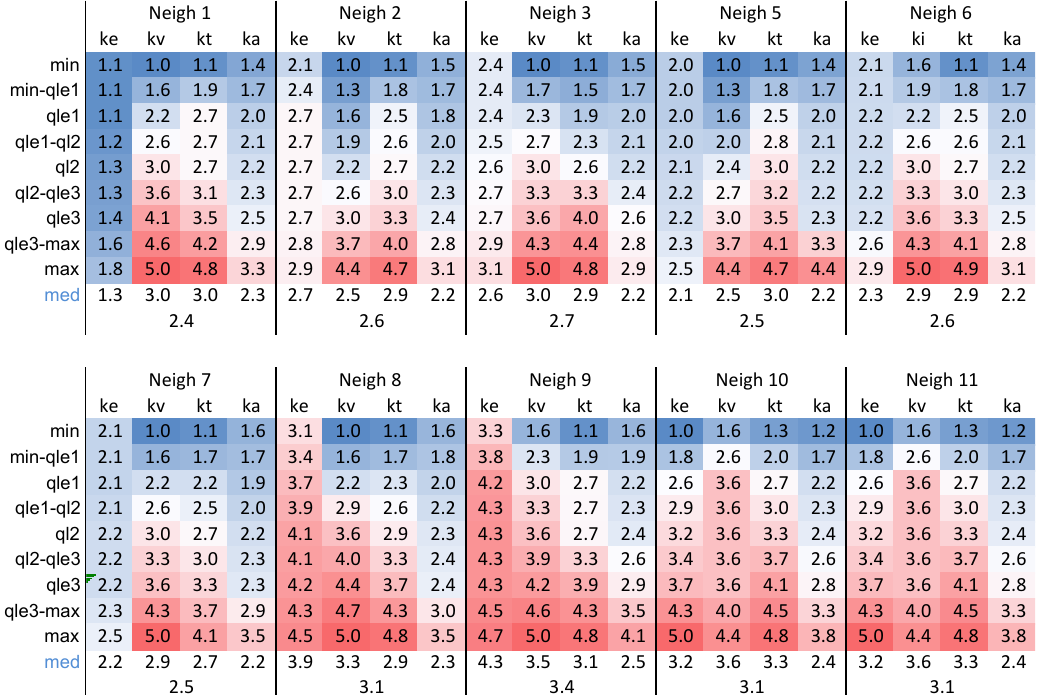
Figure 11. Cap rate by cluster: the relationship between cap rate and overall quality.